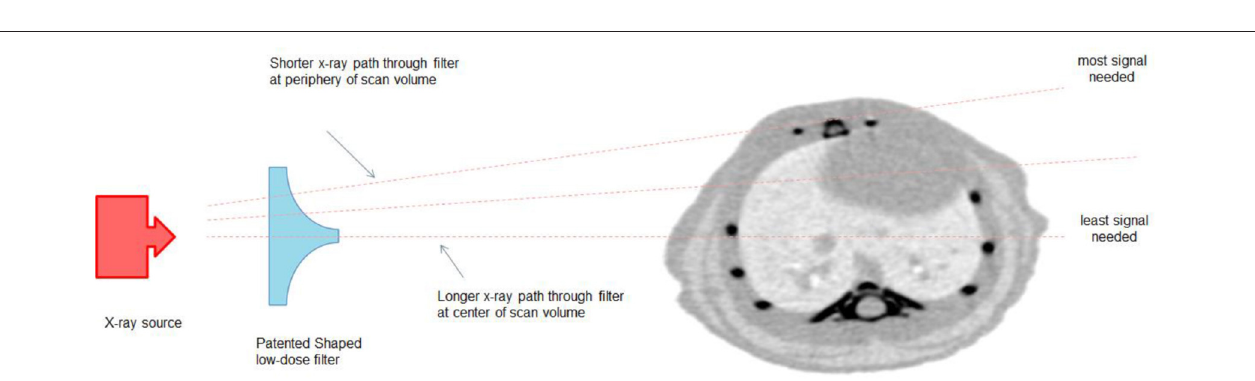
Frontiers in Medicine |